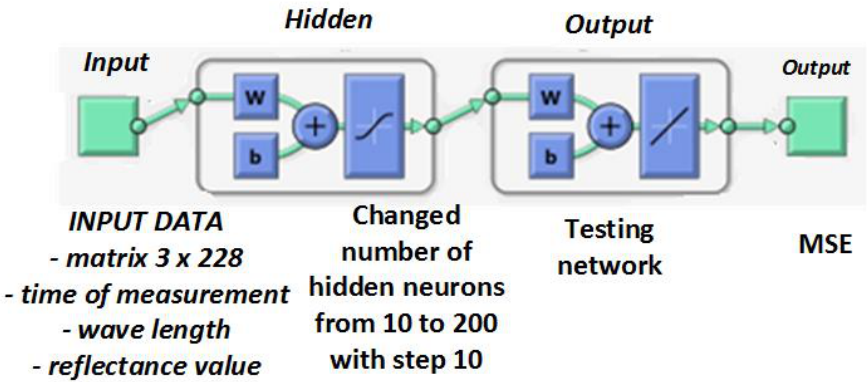
Figure 6. Structure of ANN implemented in Matlab.